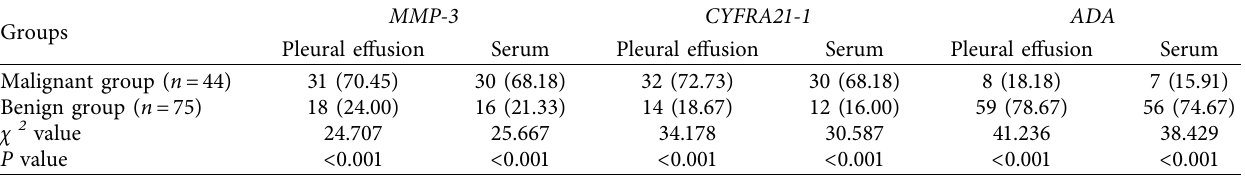
Table 2: Differential diagnostic value of pleural effusion and serum MMP-3, CYFRA21-1, and ADA in PEE. Index Pleural effusion